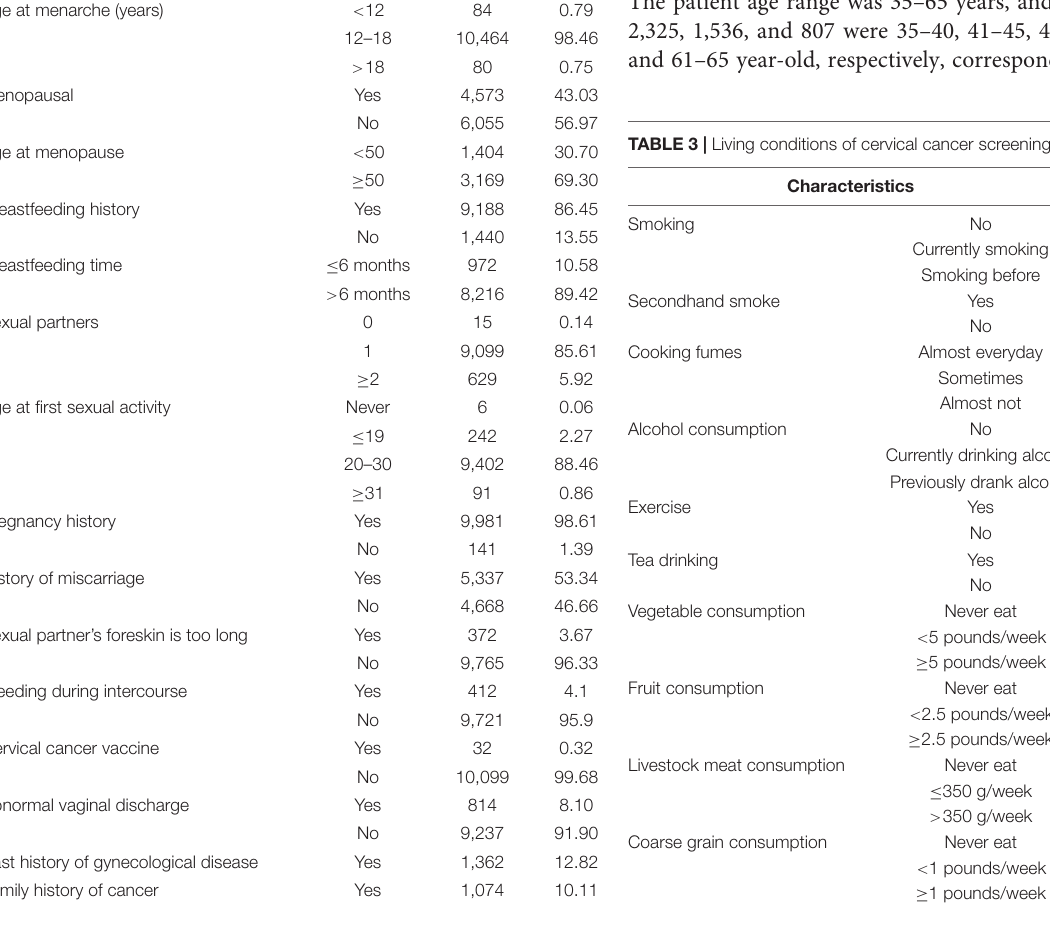
TABLE 2 | Personal history and family history of cervical cancer screening population.